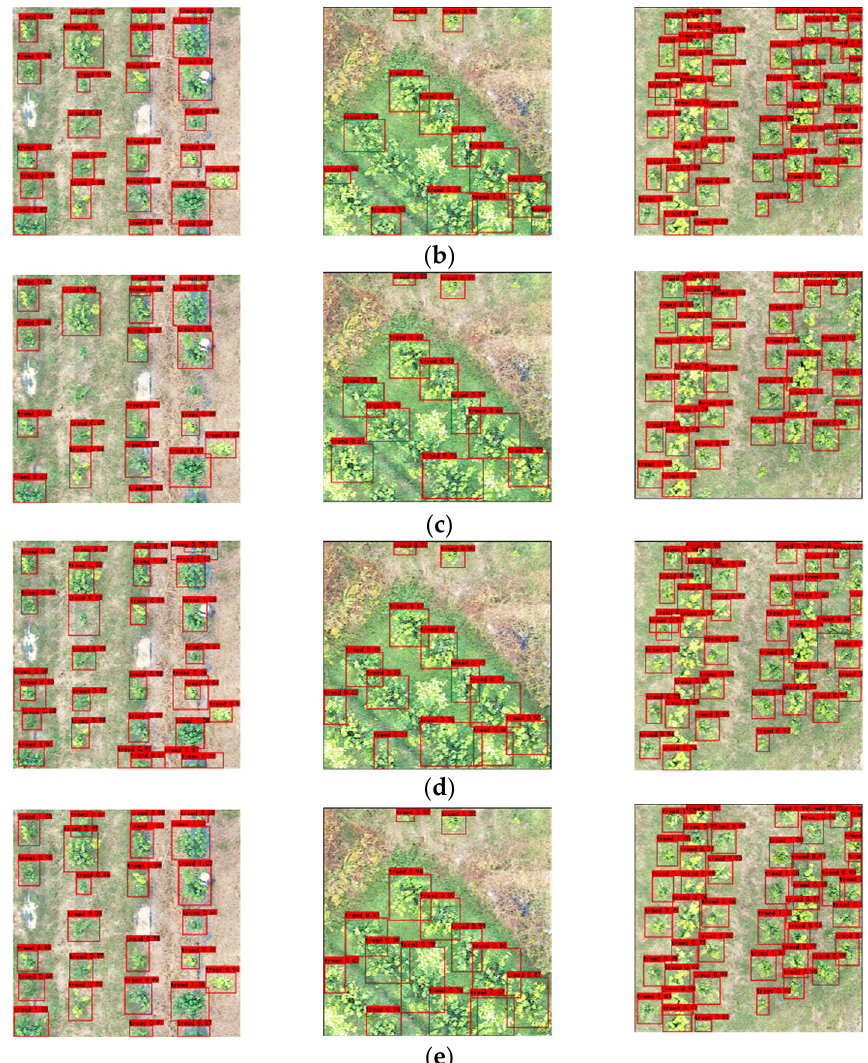
Figure 6. The recognition results of different models in different scenarios: ( a ) original images of different scenes, ( b ) detection results of YOLOv4, ( c ) detection results of YOLOv4-CBAM-Mobilenetv3, ( d ) detection results of YOLOv4-CBAM-Mobilenetv3-ASFF, ( e ) Detection results of YOLOv4-CBAM-Mobilenetv3-ASFF-P.